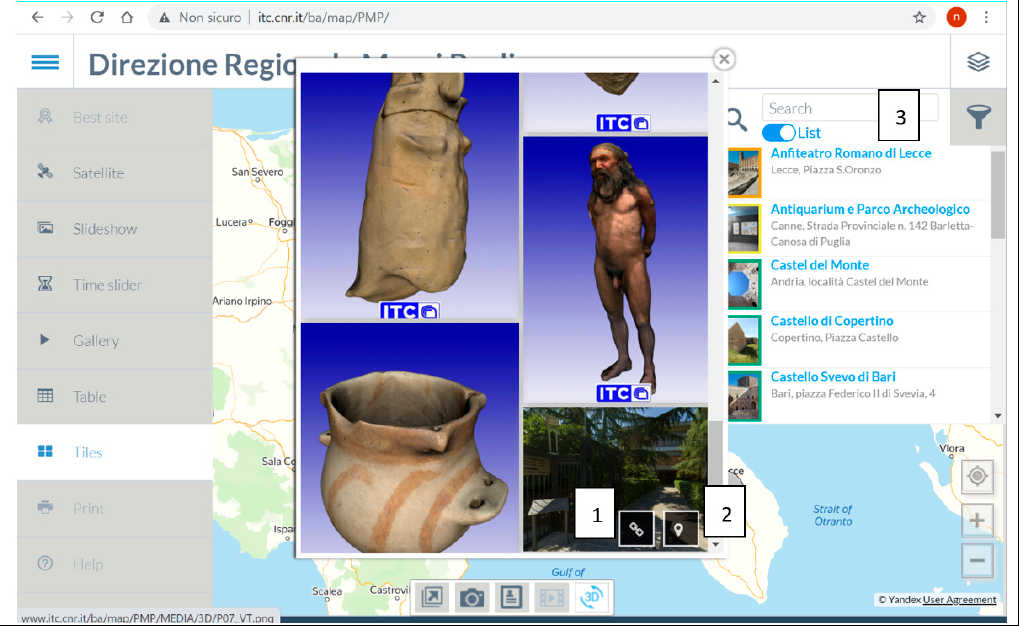
Figure 11. Multimedia interactive map of the Puglia Regional Museum Directorate [1]. The function tiles in the menu open a window showing the image previews of multimedia object pertaining all the resources. With a mouse over a preview, two function buttons are visualized: (1) Link to the relevant application (in the example, the virtual tour of the of the National Archaeological Altamura Museum); (2) Zoom in on the map to the resource the multimedia objects refer to. Those functions are also available for the multimedia object preview images in the ‘Gallery’ window and for multimedia object items listed in the ‘Table’ window. Better accessibility is